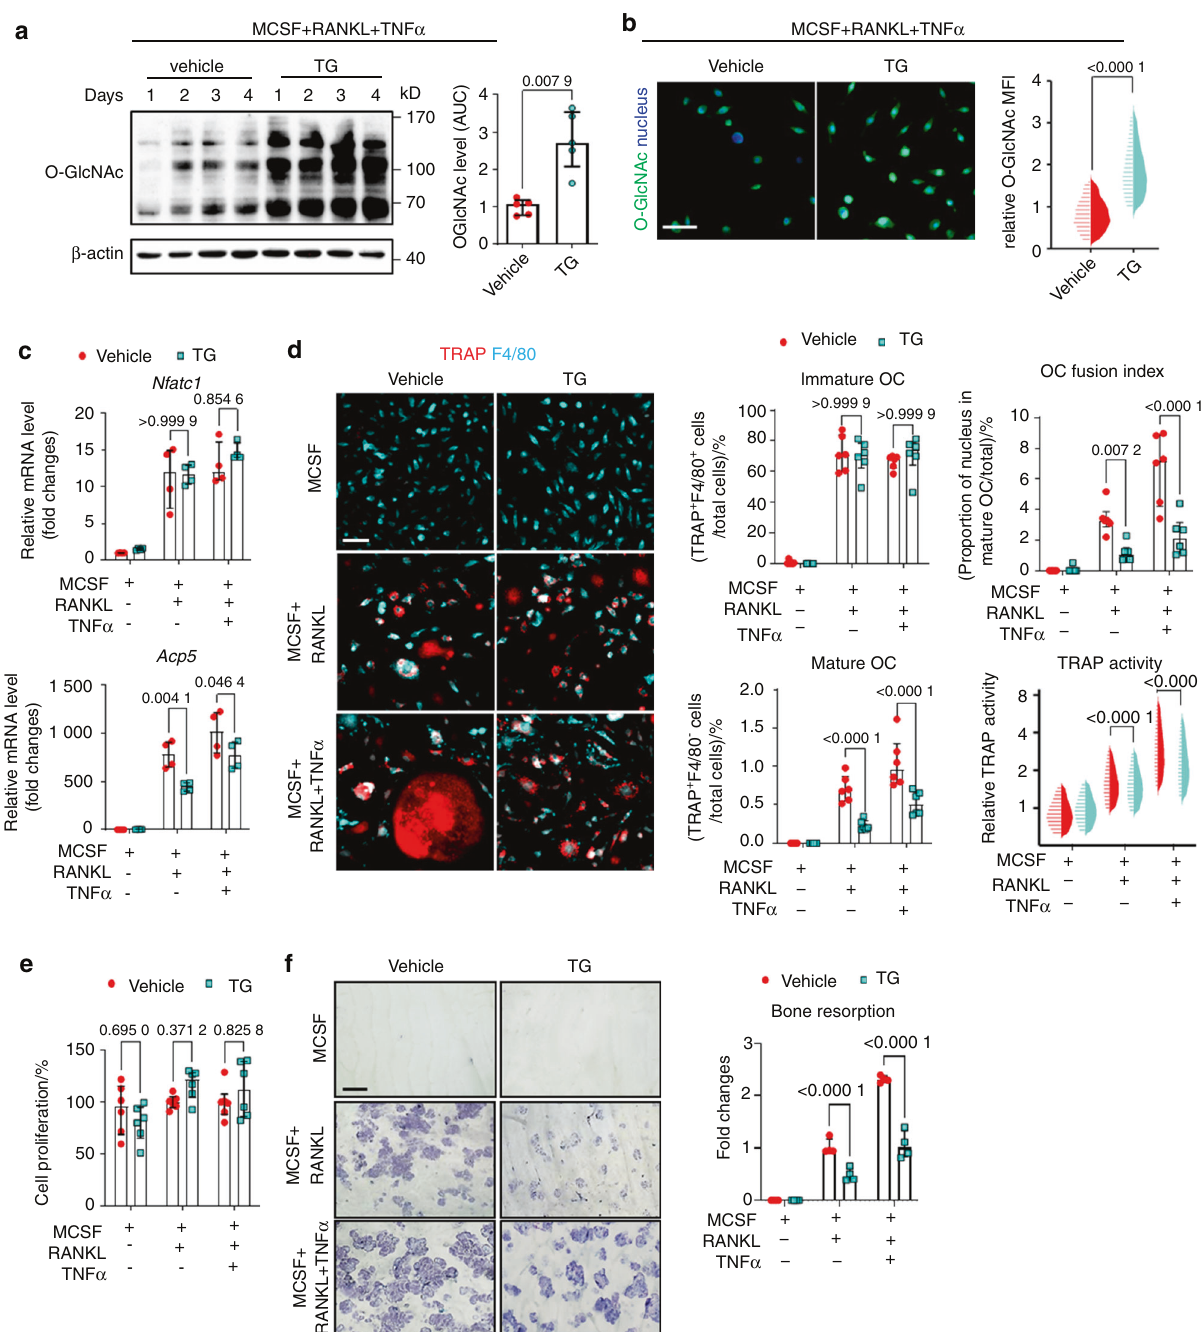
Fig. 3 Pharmacological inhibition of OGA impairs osteoclast maturation. Western blot analysis ( a ), representative images of high-content imaging, and cellomics analysis ( b ) of O-GlcNAcylation during in vitro osteoclastogenesis in the presence of TNF α and with or without Thiamet-G (TG) ( n = 5 per group for western blot; n = 17 973 cells in total for cellomics). c mRNA levels of osteoclast-related genes ( n = 4 per group). d Representative images of high-content imaging and cellomics analysis of the proportions of immature and mature OC, OC fusion index, and TRAP enzyme activity ( n = 142 807 cells in total). e Proliferation assay ( n = 6 per group). f In vitro bone resorption assay ( n = 4 per group). All bar graphs are shown as median ± IQR. Horizontal scale bars are represented as 50 µm in IF images, 100 µm in bone resorption assay. Statistical signi fi cance was determined by Mann-Whitney U-test ( a , b ) or two-way ANOVA ( c – f ). P -values are shown in the graphs. AUC area under the curve, MFI mean fl uorescence intensity, OC We con fi rmed these fi ndings by LysM-Cre driven knockout of density in the tibia bones (Fig. 4b). Histological analysis demon- OGT in osteoclast precursor cells in hTNF α tg mice 30 using bone strated less in fl ammation, reduced bone erosions, and decreased numbers of both, immature and mature osteoclasts by OSMI-1 marrow transplantation. Knockout of OGT in osteoclast pre- treatment. Immuno fl uorescence further demonstrated reduced cursors prevented in fl ammation-induced osteoclastogenesis, O-GlcNAcylation levels in OSMI-1 treated mice (Fig. 4c). ameliorated local and systemic bone loss, and reduced joint